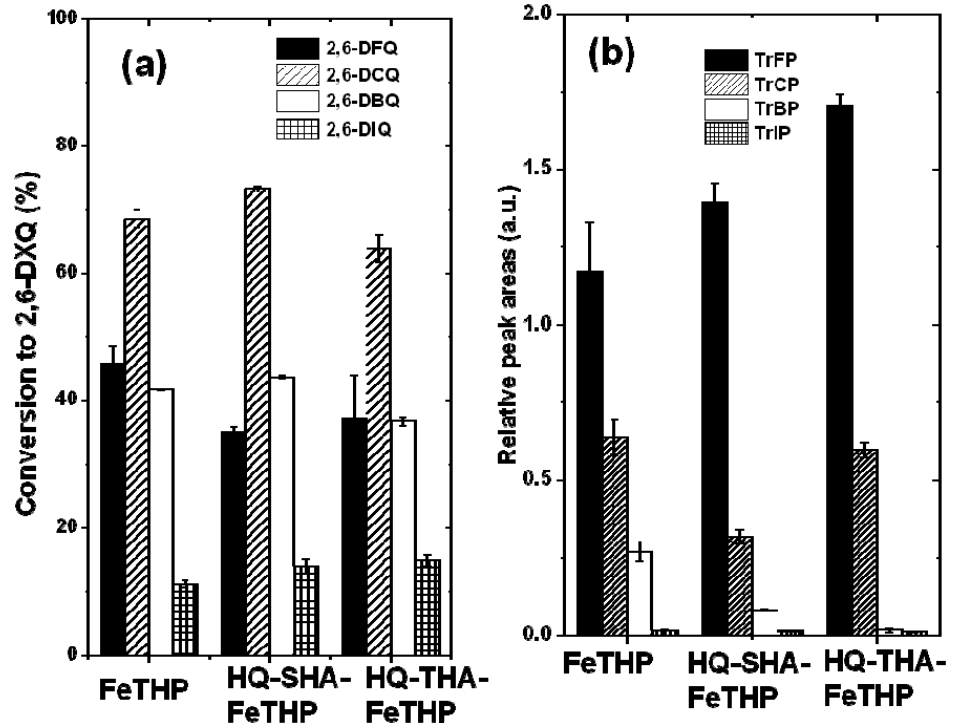
Figure 7. ( a ) Percent conversion of TrXPs to 2,6-DXQs; ( b ) Relative peak areas for the produced